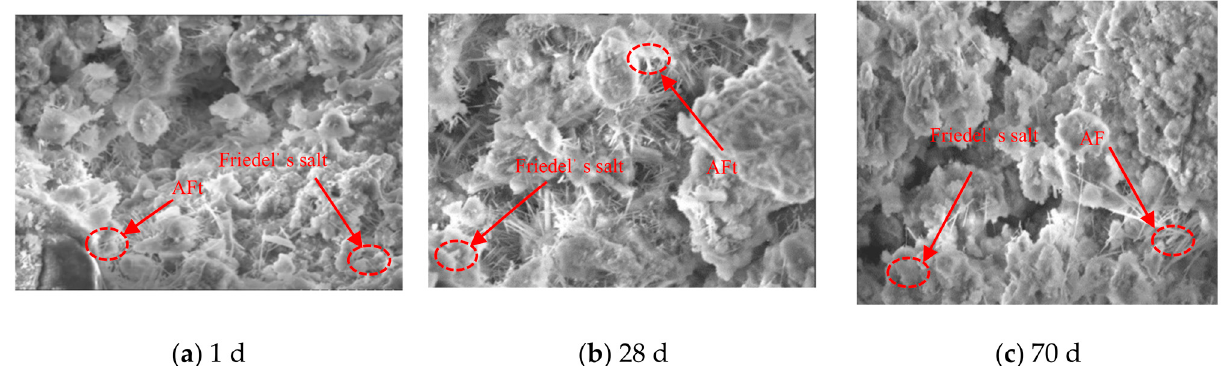
Figure 6. SEM images of T5 specimen at 1 d, 28 d, and 70 d.